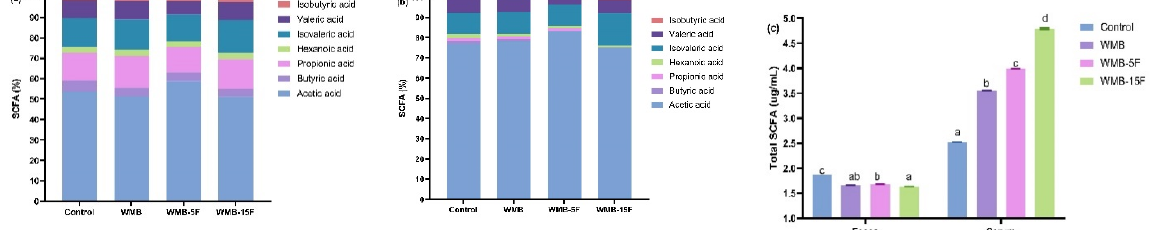
Figure 2. Relative content of short-chain fatty acids (SCFAs) in fecal ( a ) and serum ( b ) samples; total SCFA content ( c ) in mice fed with customized bread diets. Bars represented the mean ± SEM ( n = 3). Different letters implied significant difference at p < 0.05.